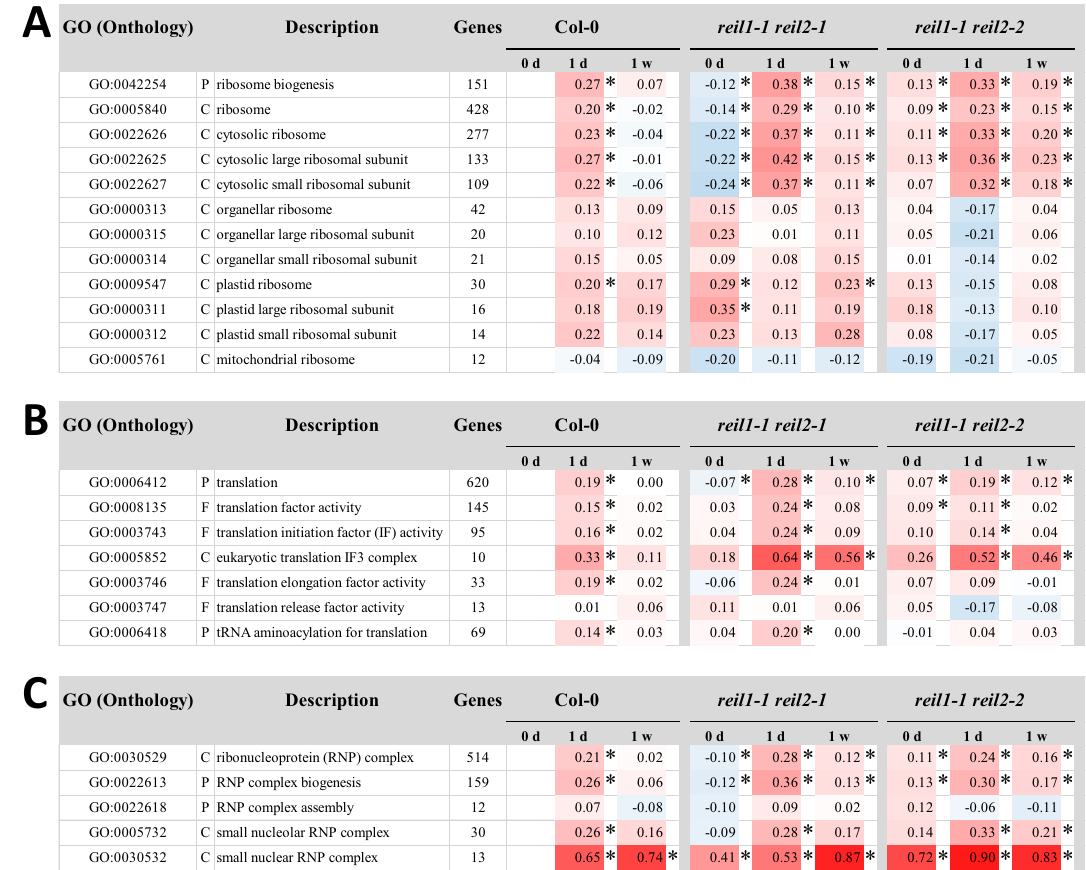
Figure 6. Functional enrichment analyses of differential gene expression in roots of Col-0, and the reil1-1 reil2-1 and reil1-1 reil2-2 double mutants in the non-acclimated state (0 day, 20 °C) and shifted to 10 °C cold for 1 day or 7 days. Differential gene expression is determined relative to non-acclimated Col-0 at optimized temperature 20 °C. ( A ) Mean log 2 -fold changes (FC) of selected ribosome biogenesis and ribosome related GO terms. Note the prolonged and stronger activation of cytosolic ribosome related genes in the mutants. ( B ) Mean log 2 -FCs of selected translation related GO terms. ( C ) Mean log 2 -FCs of selected ribonucleoprotein related GO terms. (C = cellular component, P = biological process, F = molecular function). Significant positive or negative functional enrichments, i.e. FDR-adjusted P -values < 0.05, are indicated by asterisks. The heat map color scale ranges from